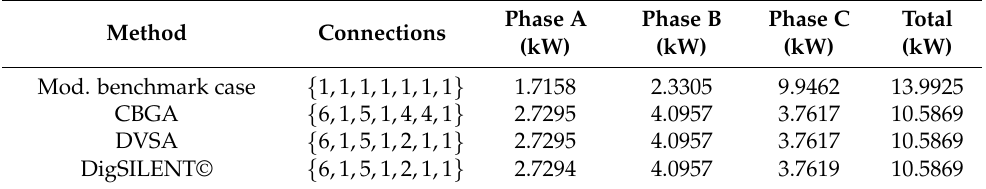
Table 11. Optimal phase-balancing results in the 8-node test